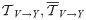

TV→Y,T¯V→Y and IV→Yflow as a function of the noise intensity σ2.The parameters of the model are T = 5, γ = m = 1, τr = 0.1 and a = −0.7.